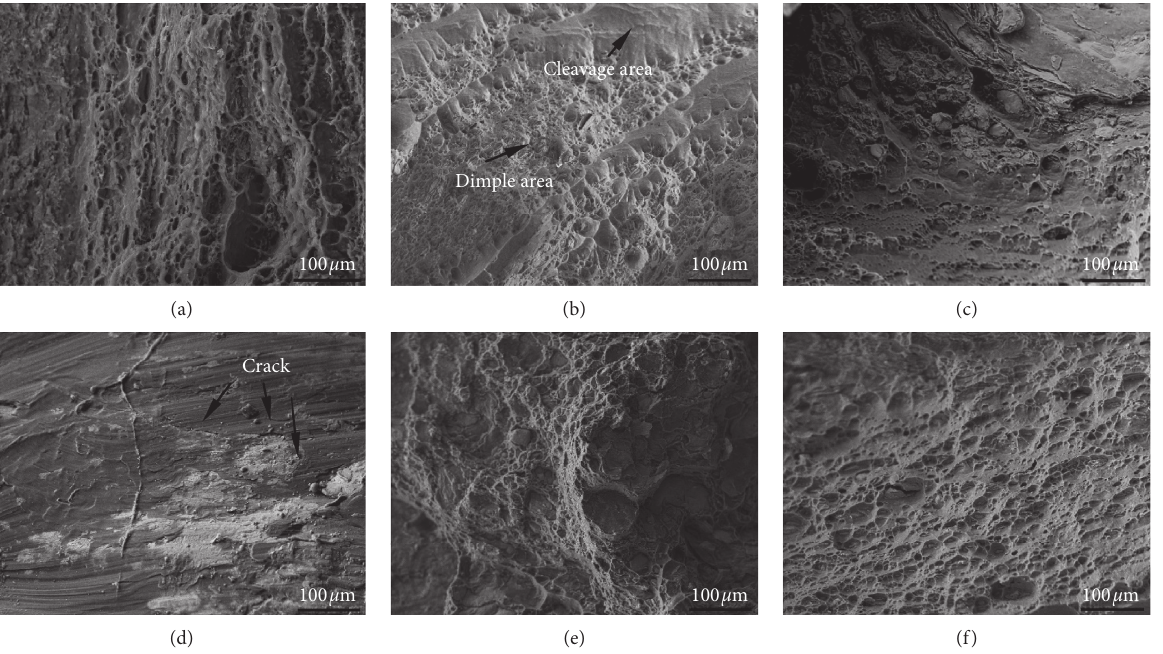
Figure 7: The fractured fracture morphology of the joints produced by (a) 750rpm-0 ° , (b) 950rpm-0 ° , (c) 1180rpm-0 ° , (d) 1500rpm-0 ° , (e) 950rpm-2 ° , and (f) 1180rpm-2 ° .